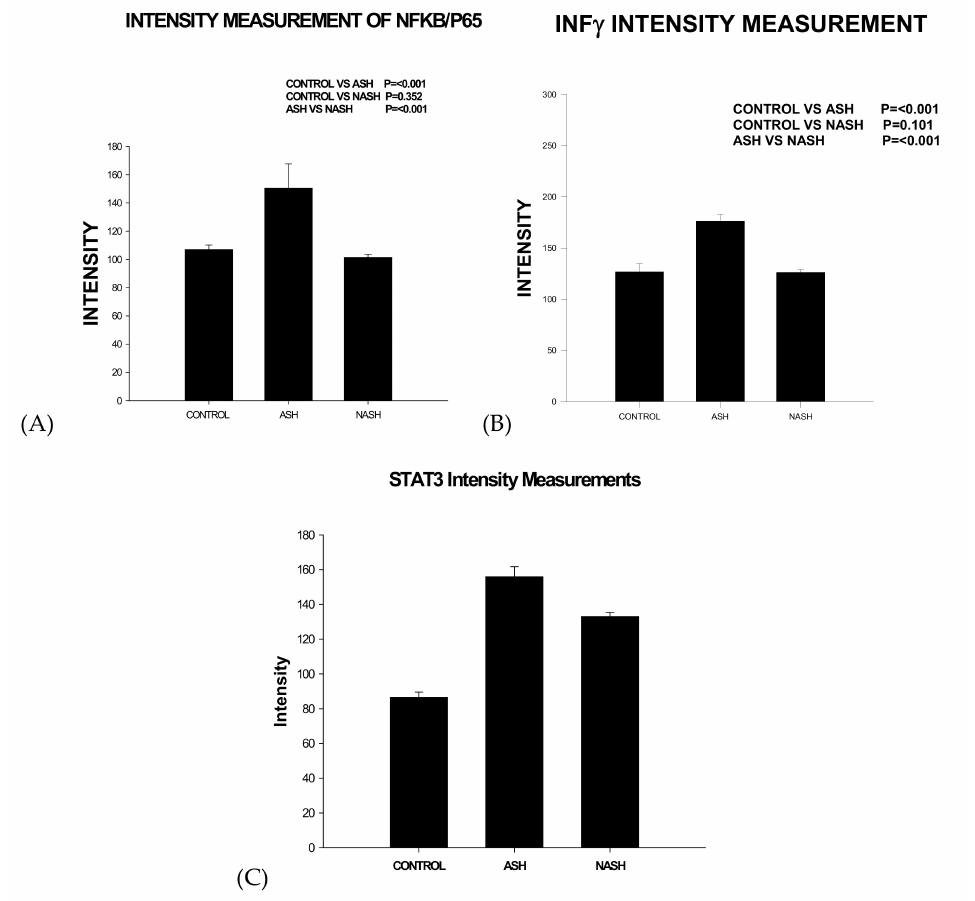
Figure 4. FAT10 expression is up-regulated by IFN γ and TNF α in intissue and express by intensity Intensity measurements in control, ASH, and NASH: ( A ) NFKb; ( B ) IFN γ ; ( C )